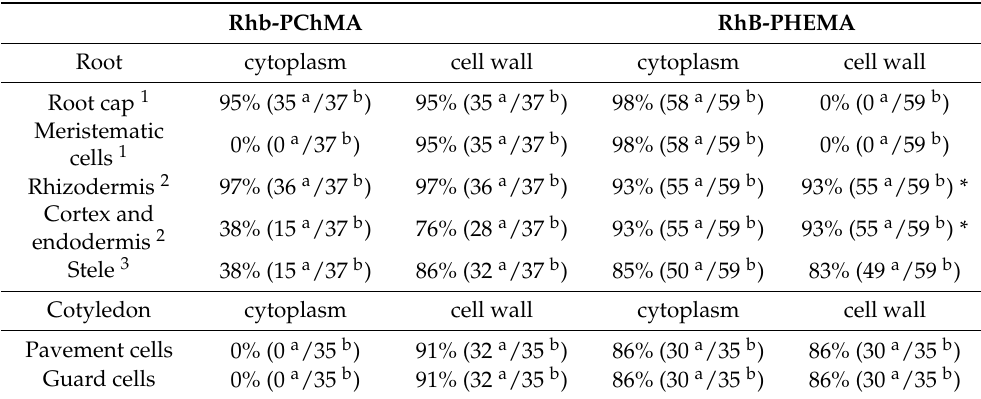
Table 3. Cellular localization of